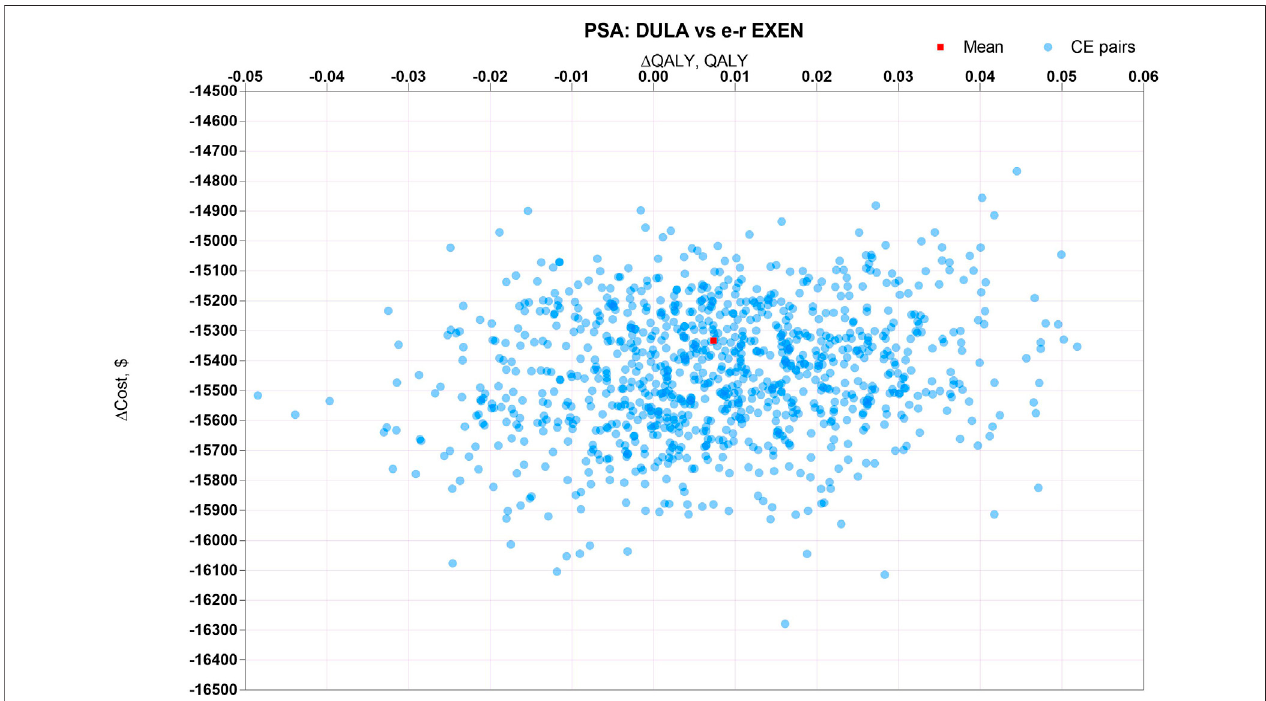
FIGURE 5 | Scatter plots of ICUR for sc. DULA vs. e-r